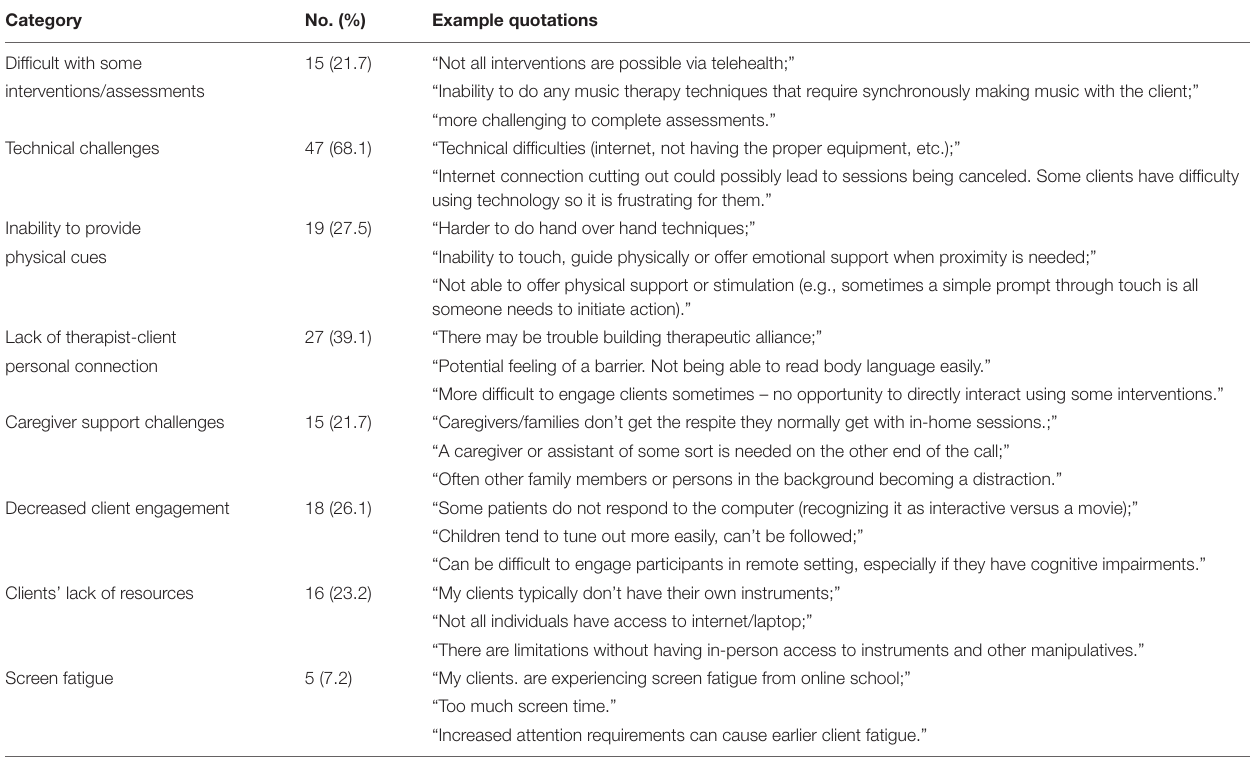
TABLE 8 | Challenges of